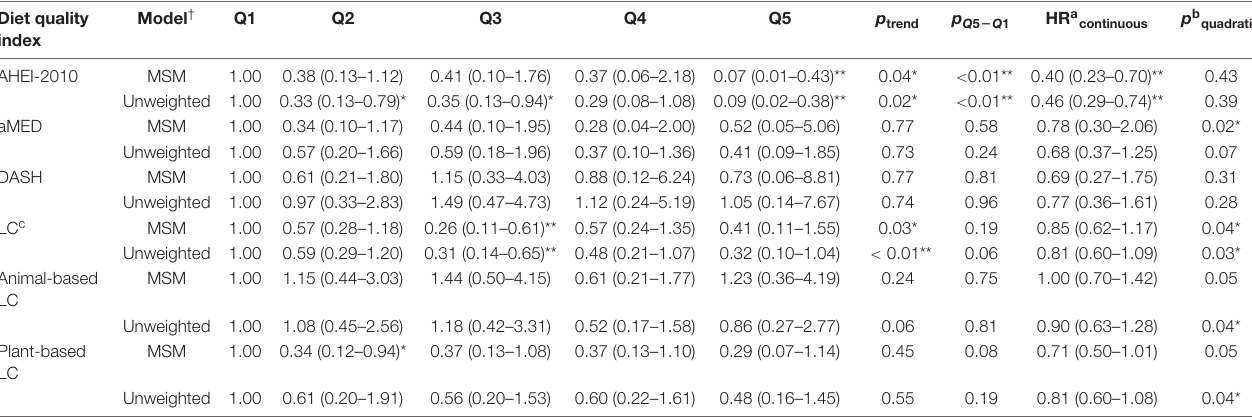
TABLE 3 | Hazard ratios † (HRs) and 95% CIs for all-cause mortality from both marginal structural models and unweighted models across each dietary index.